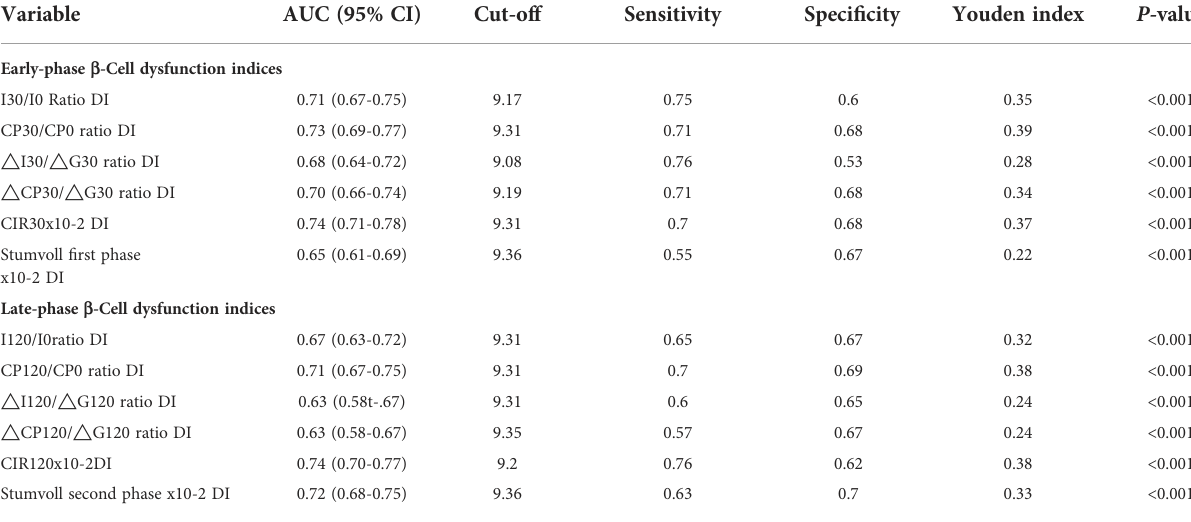
TABLE 4 Comparison of the ability of TyG to predict b -cell